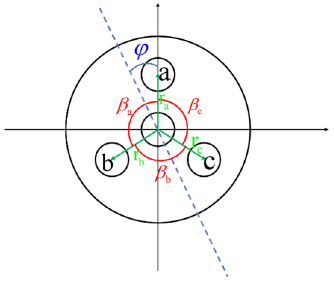
Figure 3. Section of the FBG sensing point whilst bending.